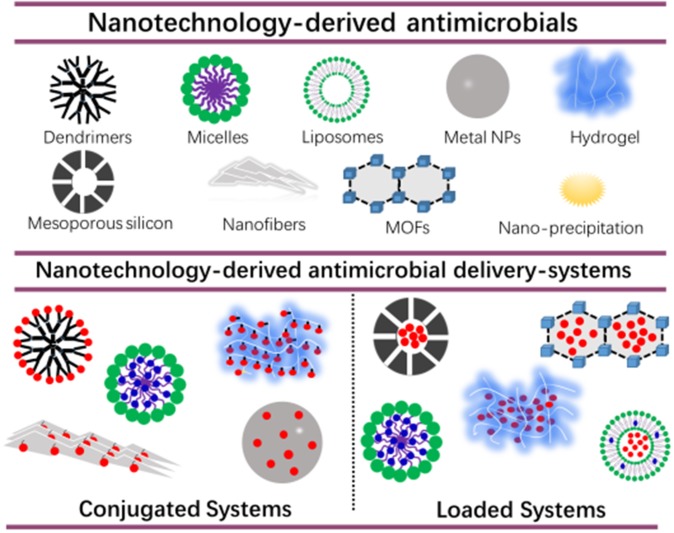
Nanotechnology-derived antimicrobial delivery-systems, including nanofiber-composed hydrogels. Delivery-systems are divided into systems in which antimicrobials are conjugated to a carrier or loaded into a carrier. Hydrophobic and hydrophilic antimicrobials are indicated in blue and red, respectively.